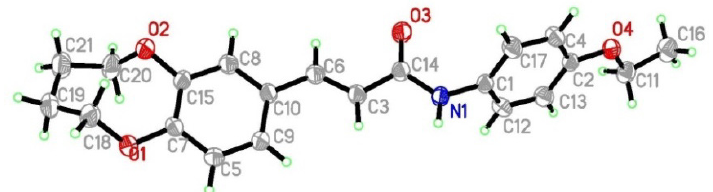
Figure 1. Crystal structure diagram of compound D